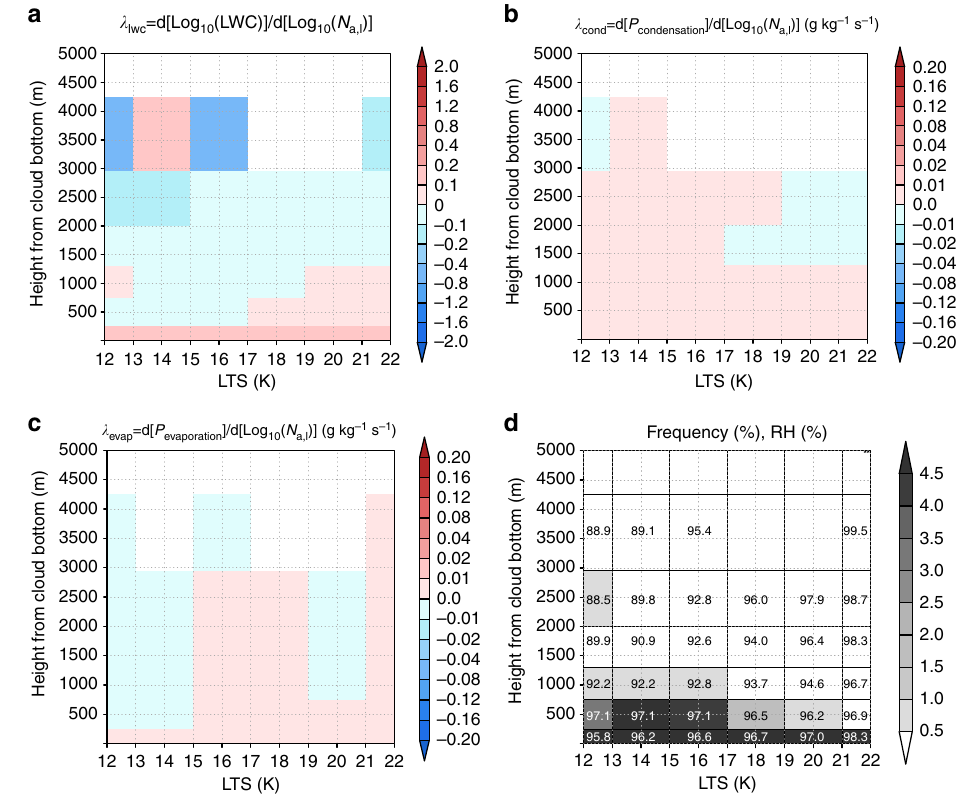
Fig. 3 The vertical distribution of variables to explain the reasons for the positive value of λ by the global climate model. Distribution of the a λ lwc , b response of the condensation tendency ( P condensation ) to aerosol perturbations ( λ cond ), c response of the evaporation tendency ( P evaporation ) to aerosol perturbations ( λ evap ), and d frequency and relative humidity (RH) over the lower tropospheric stability (LTS)-height from the cloud bottom plane. The number in each grid of d indicates the RH (%) simulated by the GCM. The results over the ocean between 60 o S to 60 o N were used for creating these fi gures. The cloud bottom was determined as the lowest layer of the grid where the average liquid water content (LWC) was larger than 10 − 5 kg kg − microphysical scheme. Large scale condensation 27 and cumulus parameterisation 32 were applied in the GCM. In the schemes, q v , q c , q i , the cloud droplet number concentration ( N c ), and the number concentration of ice ( N i ) were predicted. In the GRCM, saturation adjustment was applied, and the impacts of the aerosol on cloud microphysical properties were represented by reducing the autoconversion rate with increasing aerosol number concentration as follows. The